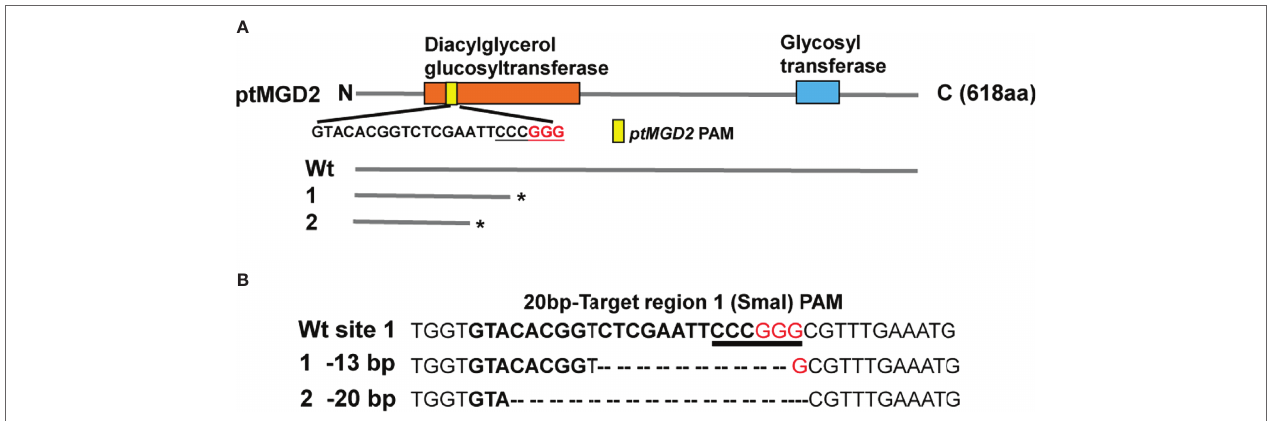
FIGURE 3 | Targeted mutagenesis of ptMGD2 using CRISPR/Cas9 system. (A) Domain architecture of the ptMGD2 protein. The domain analysis was performed with InterProScan and different domains are represented by different colors. The protein lengths are displayed on the right. The nucleotide sequence of the PAM1 target site in the first exon of ptMGD2 is also shown. Compared with wild type (Wt), these two mutations resulted in the early termination of protein translation at Diacylglycerol glucosyltransferase domain. (B) The CRISPR/Cas9-based mutagenesis of ptMGD2 were designed targeting the coding sequence of the ptMGD2 and two mutants were detected by SmaI digestion and DNA sequencing. DNA sequences of the target region with PAM and base pairing sequence of sgRNA are shown in red and bold between Wt and mutants. *The early termination of protein